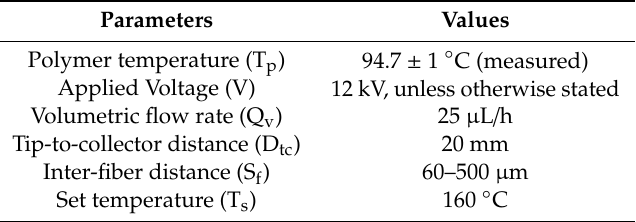
Figure 1. Schematic representations of the melt electrohydrodynamic system and the cold plate: ( a ) composition of melt electrohydrodynamic system; ( b ) cold plate with its dimensions. Table 1. The parameters and their values or range in the melt electrohydrodynamic process.